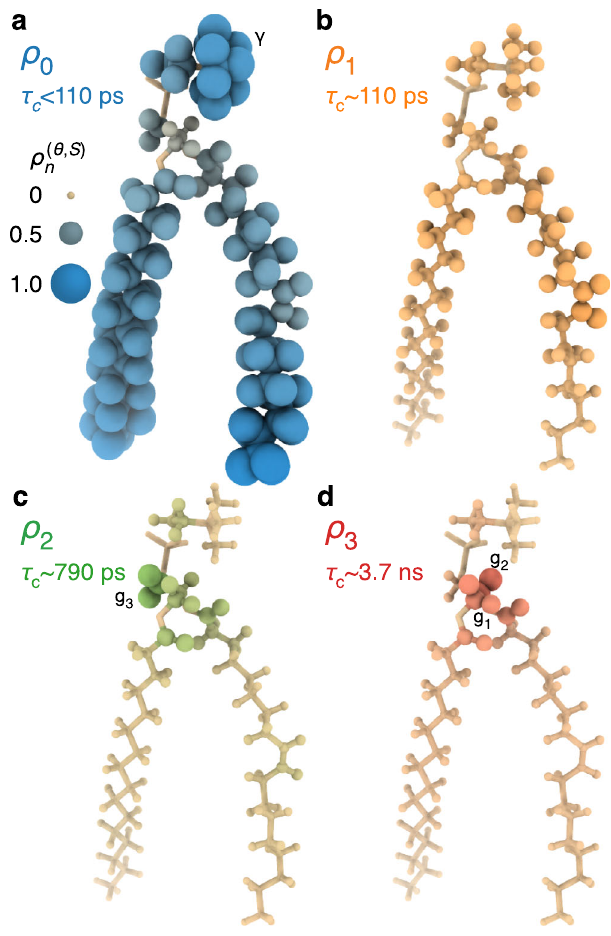
Fig. 2 Detector responses mapped onto the individual segments of a POPC molecule. Panels a – d show responses corresponding to ρ 0 , ρ 1 , ρ 2 , and ρ 3 , respectively. Each plot encodes the detector responses found in Fig. 1, where the radii of the H and C nuclei are proportional to ρ ð θ ; S Þ n , and we fade from tan to color, depending linearly on ρ ð θ ; S Þ n . The radius scale is indicated in the upper left of the fi gure. In cases where experimental data are ambiguous (some chain methylene segments), we plot MD-derived responses, noting that these responses are in very good agreement with the experiment (see Fig. 1). All 3D plots are produced with ChimeraX 67 . Source data are provided as a Source Data